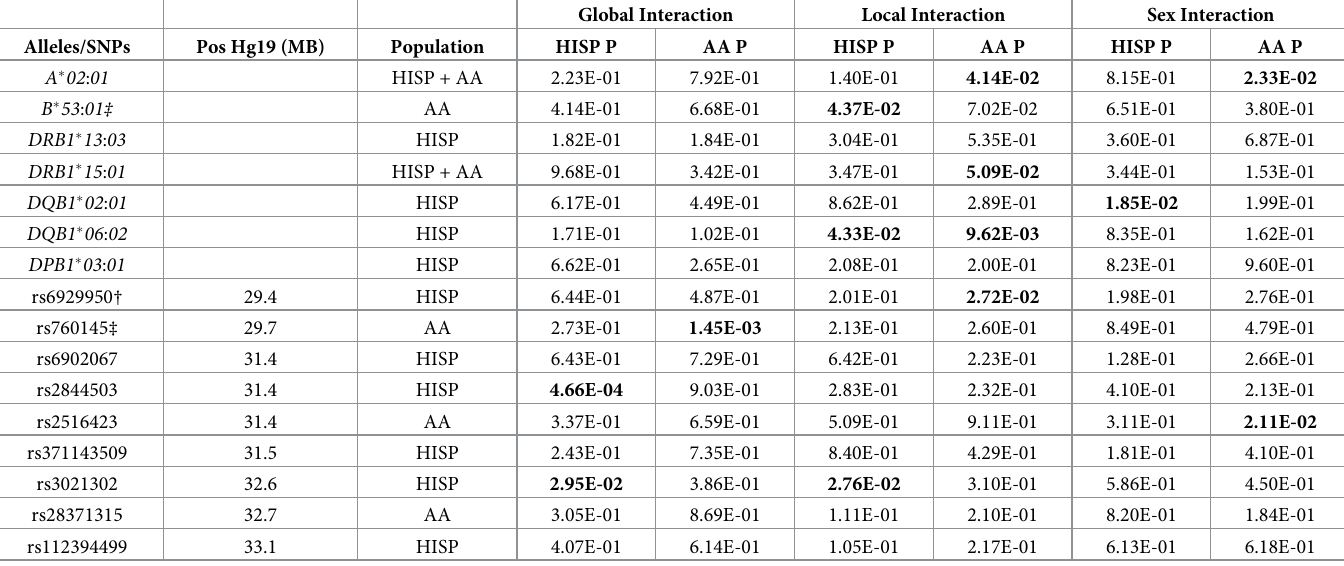
and controls peaking between the Class I and Class III gene regions (minimum observed LRT p = 2.99 x 10 − 05 from 31.51 to 31.56 MB, Fig 3A). In accordance with previous reports in the literature of MHC-specific admixture-enabled selection due to rapid adaptive evolution [31], relative to global ancestry, we observed an increase in local African ancestry and a decrease in local European ancestry for both MS cases and controls across the entirety of the MHC (Fig 3B). However, the magnitude of the divergence of local ancestry from global ancestry differs by MS status. Relative to controls, MS cases had an increase in both EUR and AFR ancestry (average increase of 4.5% EUR and 1% AFR in MS cases relative to controls), in conjunction with a substantial decrease in NAM ancestry (average decrease of 5.5% in MS cases relative to controls, LRT p < 0.01 from 31 to 32.6 MB). Table 3. Interactions with MHC risk